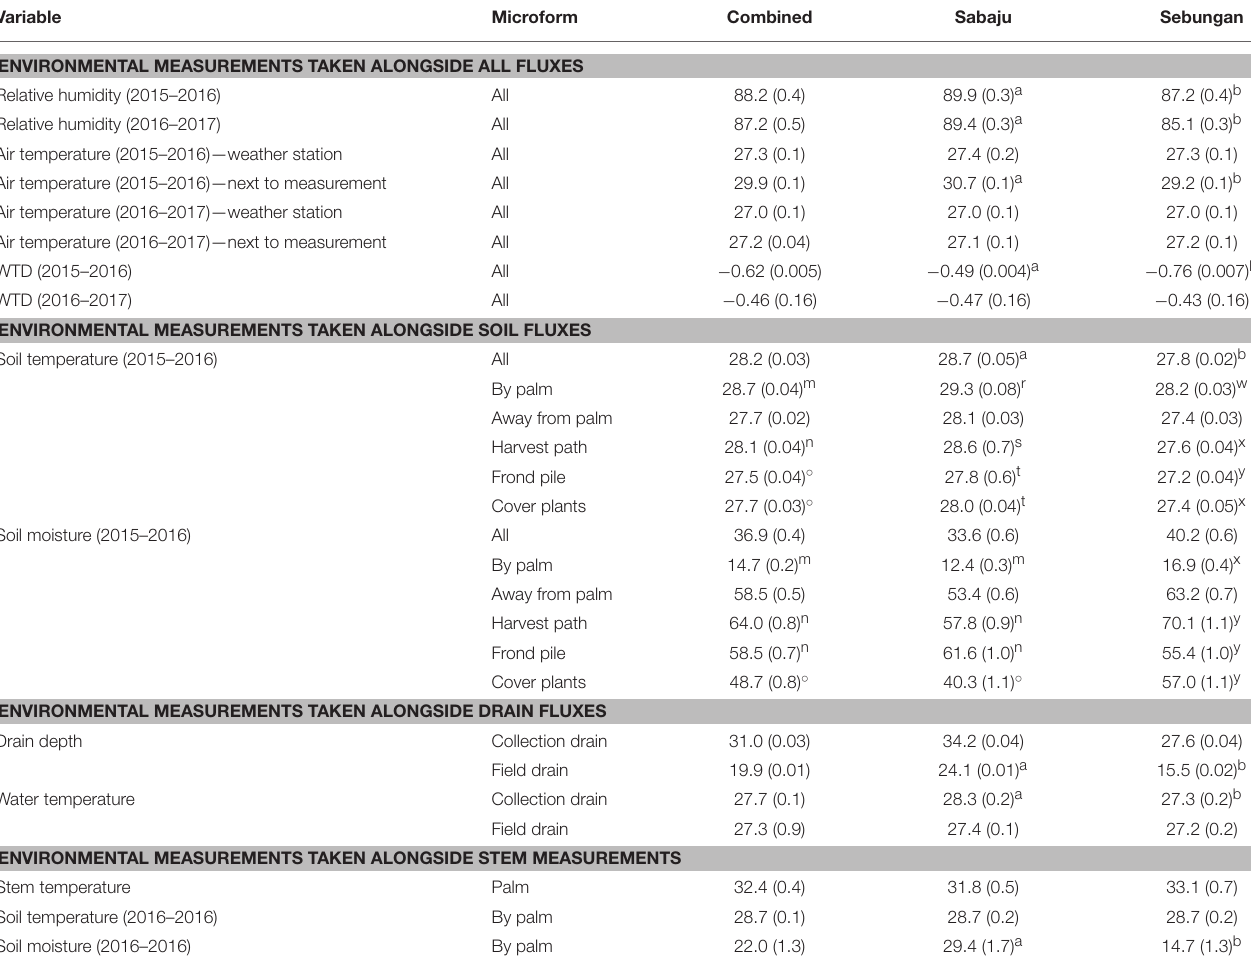
TABLE 1 | Mean environmental variables measured from the two plantations, both combined and from Sabaju and Sebungan individually. Variable